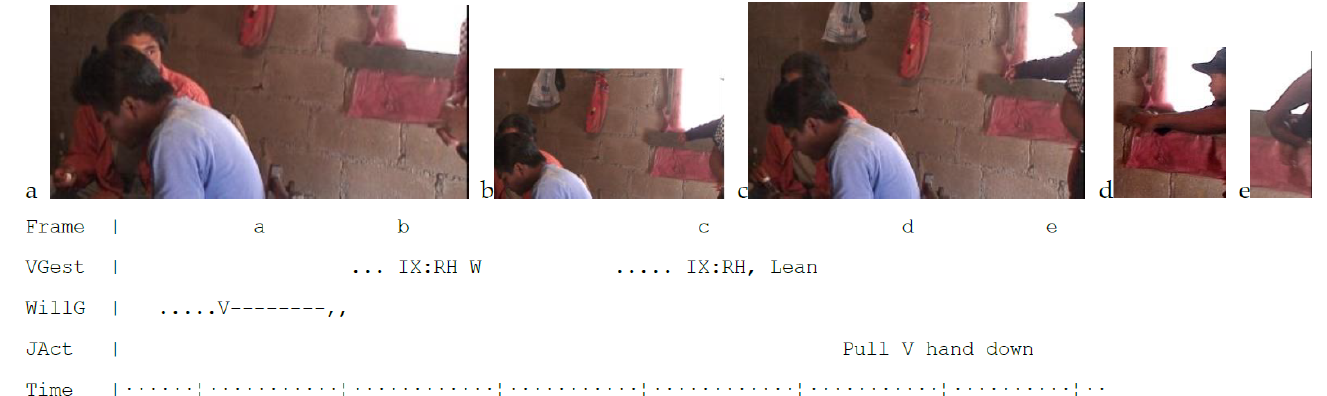
Figure 6. Vic at 11 mos. pointed at Will and was restrained. ( a ) Will had glanced up to meet Vic’s gaze, establishing apparent brief eye contact. ( b ) Vic’s raised “pointing” hand appeared. ( c ) Vic re- peated the pointing gesture insistently a second time. ( d ) Jane reached up quite deliberately, ( e ) to pull his hand down.